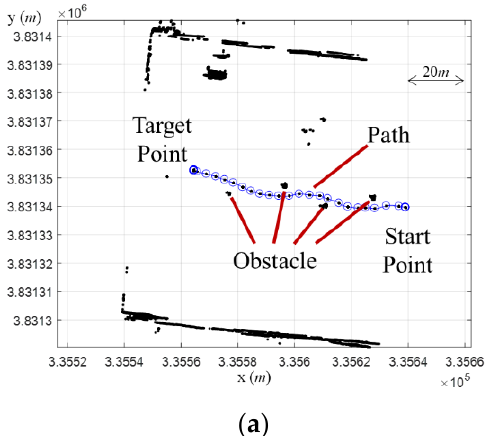
Figure 11. Avoiding multiple obstacles.